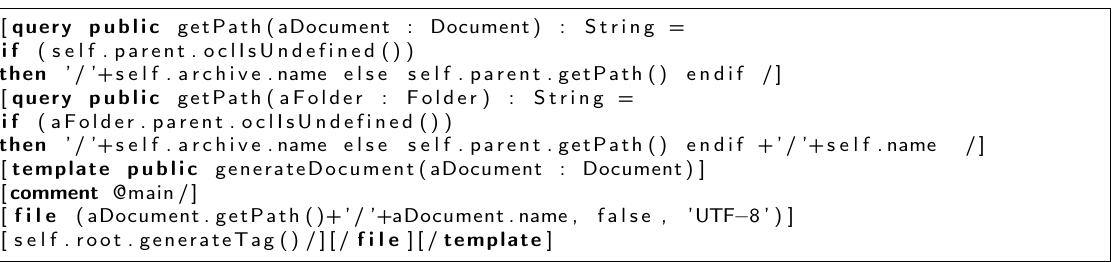
Figure 7. XML document generation template in ACCELEO.